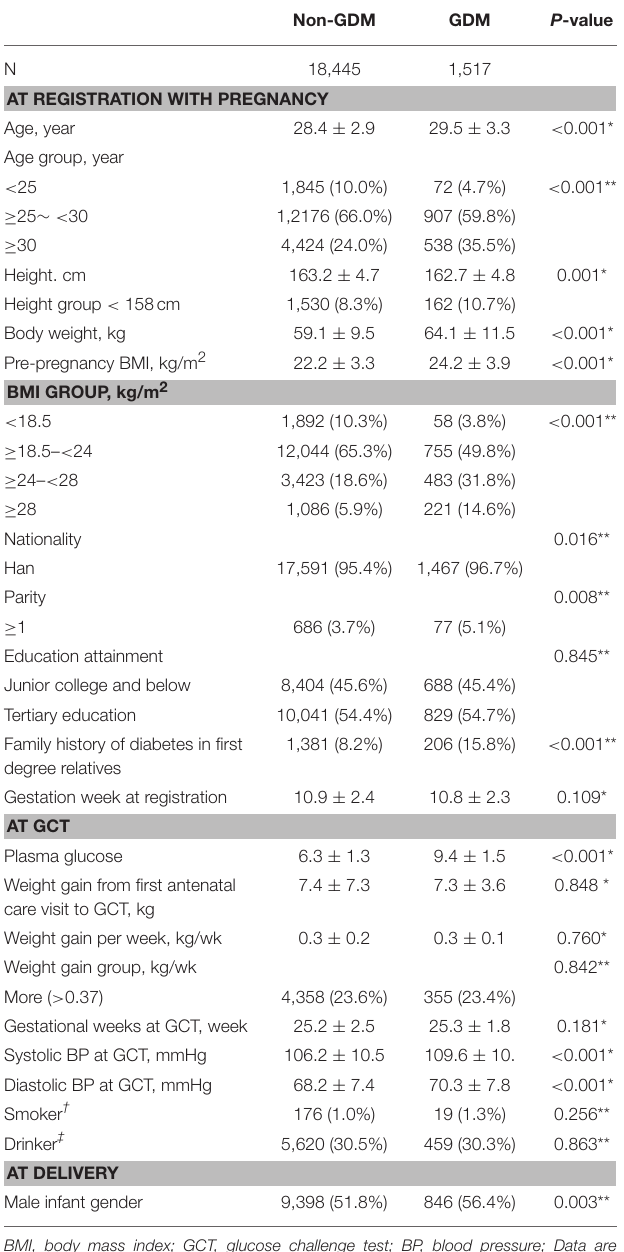
TABLE 1 | Clinical and biochemical characteristics of subjects according to occurrence of gestational diabetes mellitus diagnosed by the IADPSG’s criteria. Non-GDM GDM P -value